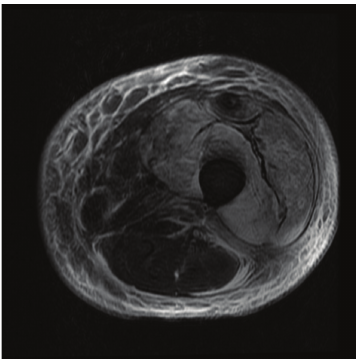
Figure 1: T 2 -weighted magnetic resonance image: transverse view of the left thigh: demonstrating di ff use edema in the anterior compartment and subcutaneous edema in the anterior and lateral aspects of the thigh.